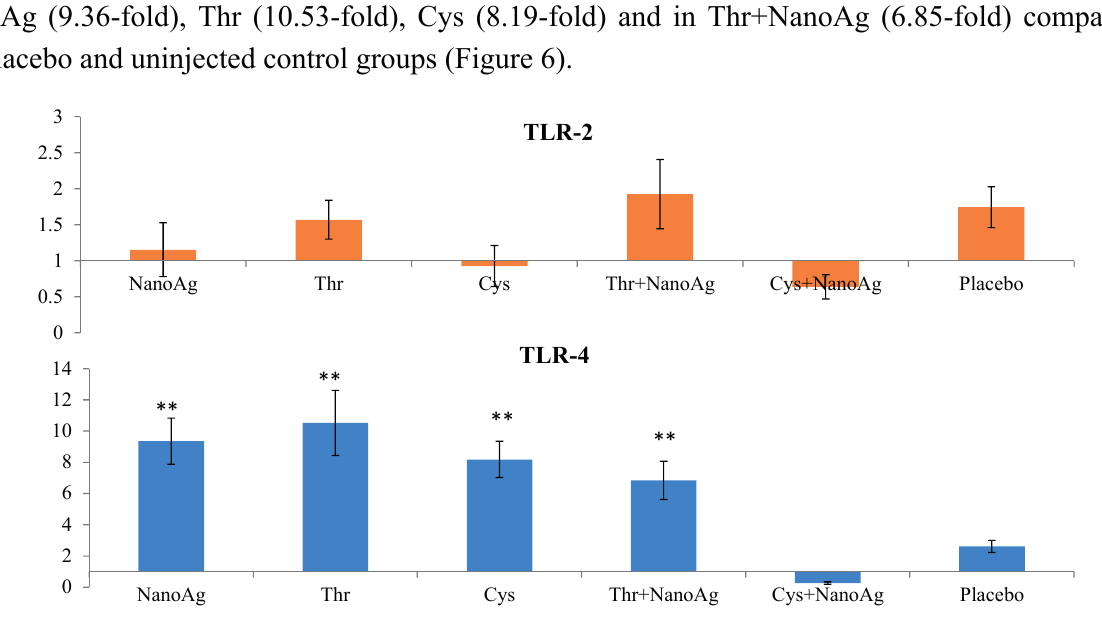
Figure 6. Relative fold expression level of toll like receptor-2 ( TLR-2 ) and toll like receptor-4 ( TLR-4 ) gene in spleen tissues of LPS induced in ovo NanoAg and/or amino acid injected embryos. Expression of uninjected control embryo is taken as 1.0. ** indicates significant expression at the level of 99% ( p <